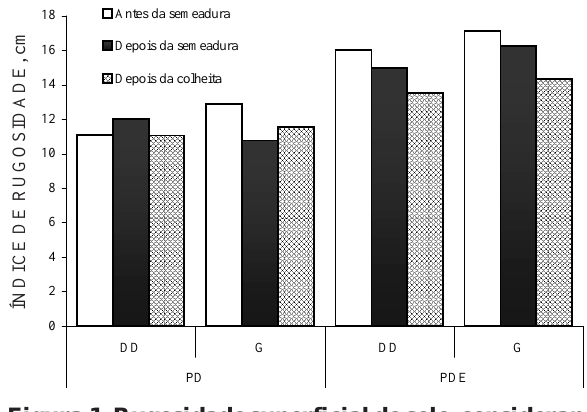
Figura 1. Rugosidade superficial do solo, consideran- do o manejo de plantio direto (PD), plantio di- reto escarificado (PDE) e mecanismos sulcadores: guilhotina (G) e duplo disco